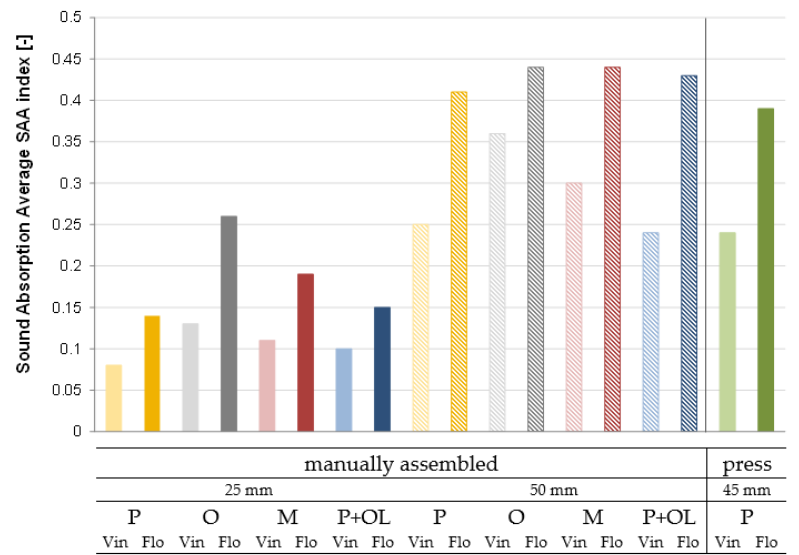
Figure 7. Sound absorption average (SAA) index of the investigated panels.